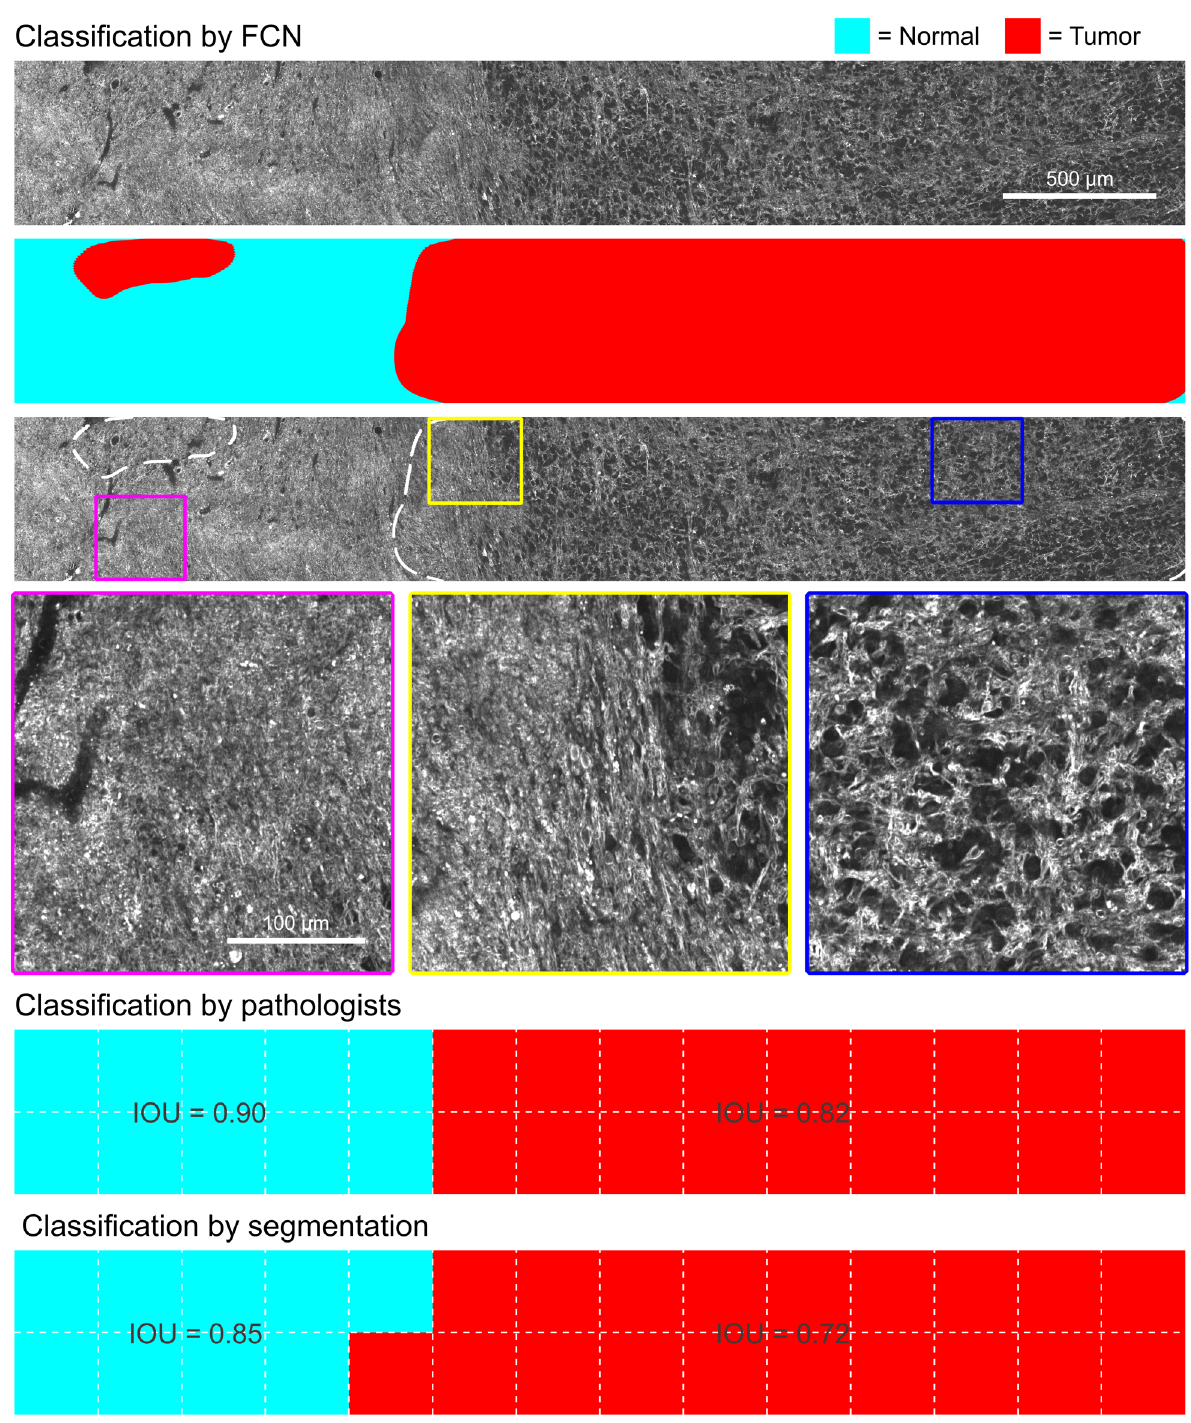
Figure 5. Semantic segmentation of low-grade glioma infiltration for test set case. Mosaic taken from test case 6 (see Supplementary Table S1). The mosaic shows clear gradually increasing density of tumor cells from histologically normal brain tissue (purple square) to tumor tissue (blue square). The tumor boundary (yellow square) is correctly identified by the FCN, as compared to the consensus of the